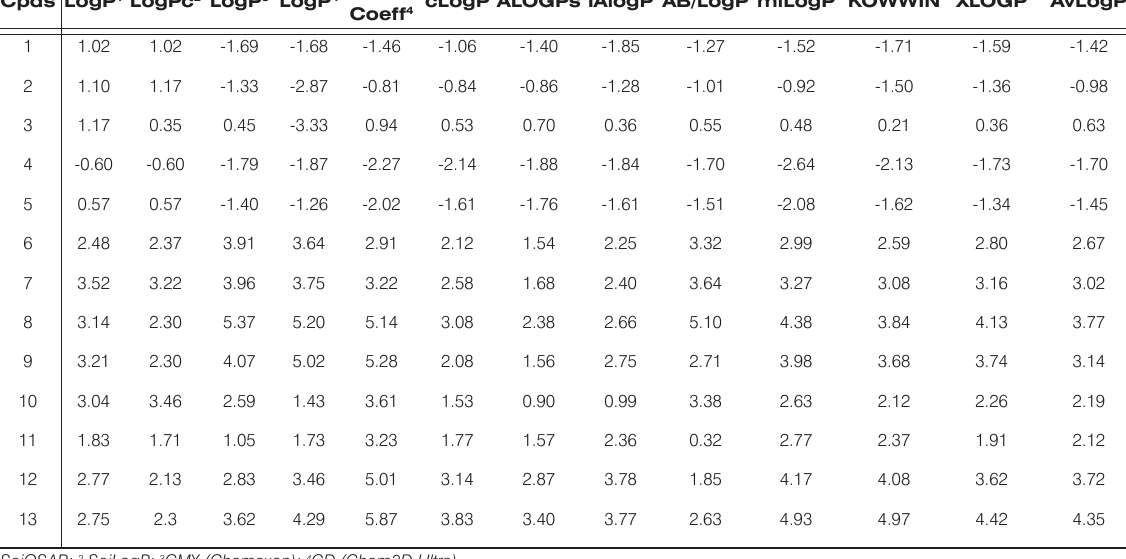
Table 3. Computed Log P values using different computer programs